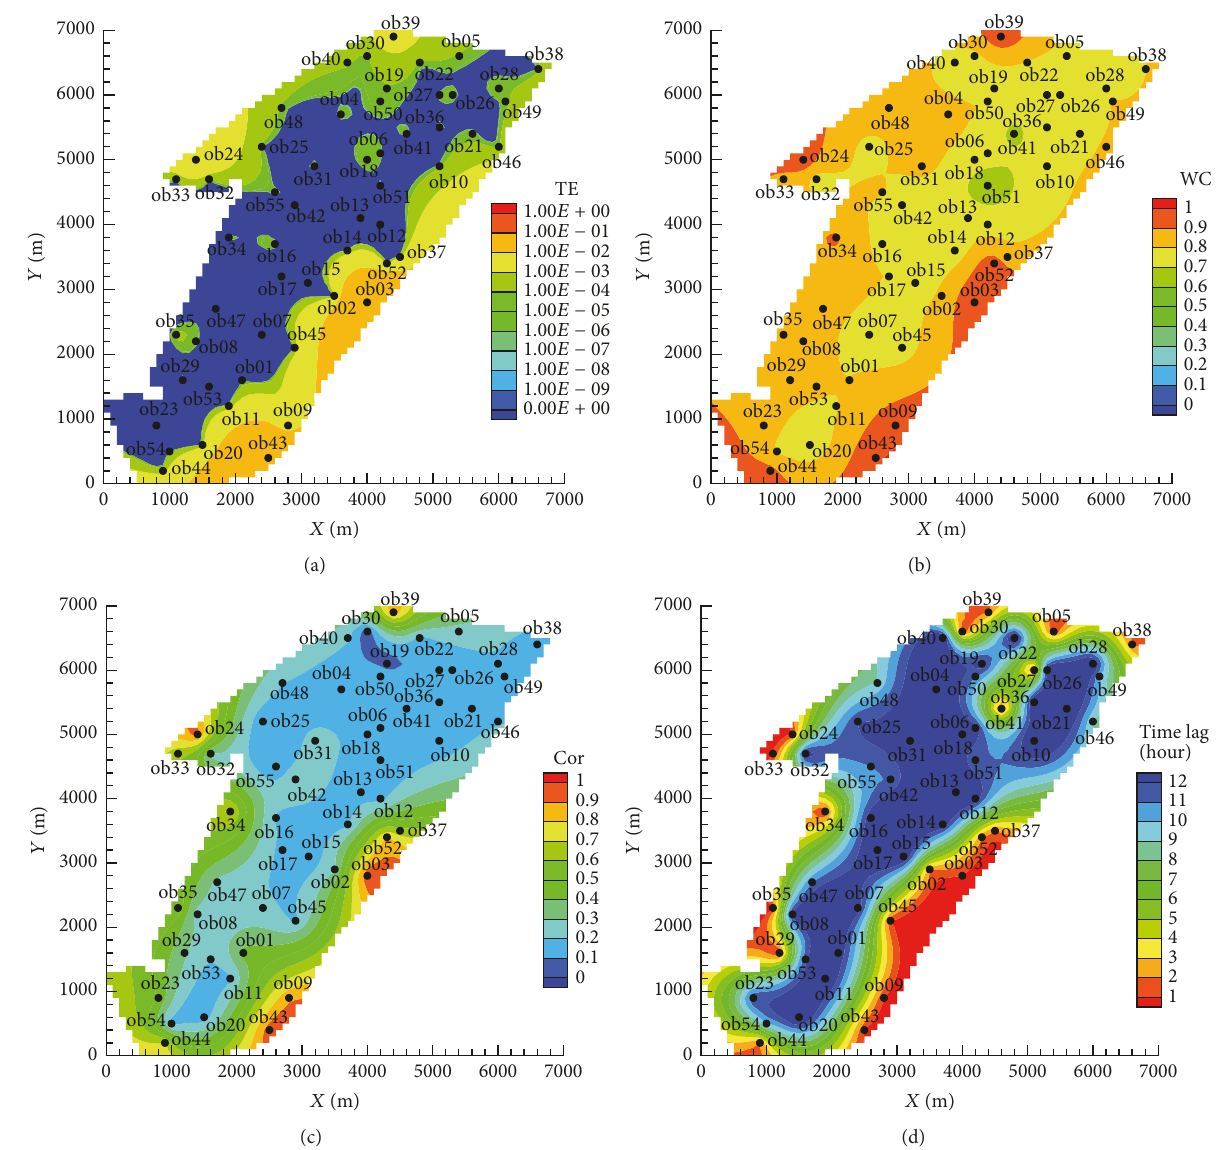
Figure 7: Spatial distributions of the groundwater level affected by tidal fluctuation. (a) Tidal efficiency (TE) results based on the continuous wavelet transform (CWT) approach between the groundwater and tidal levels; (b) wavelet coherence (WC) results based on the wavelet coherence approach between the groundwater and tidal levels; (c) first maximum cross-correlation results between the groundwater and tidal levels; and (d) time lag results between the groundwater and tidal